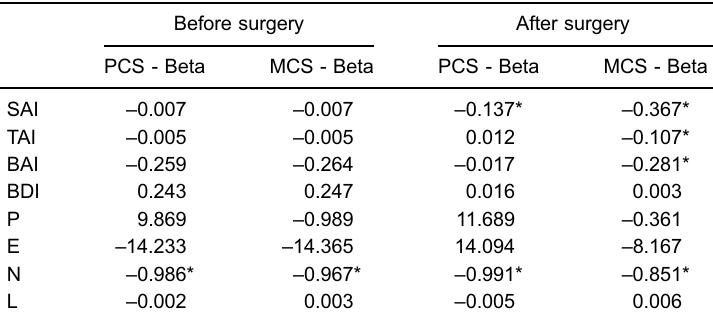
Table 3. Multiple linear regression analysis of psychological and psychic factors with health-related quality of life. Before surgery After surgery